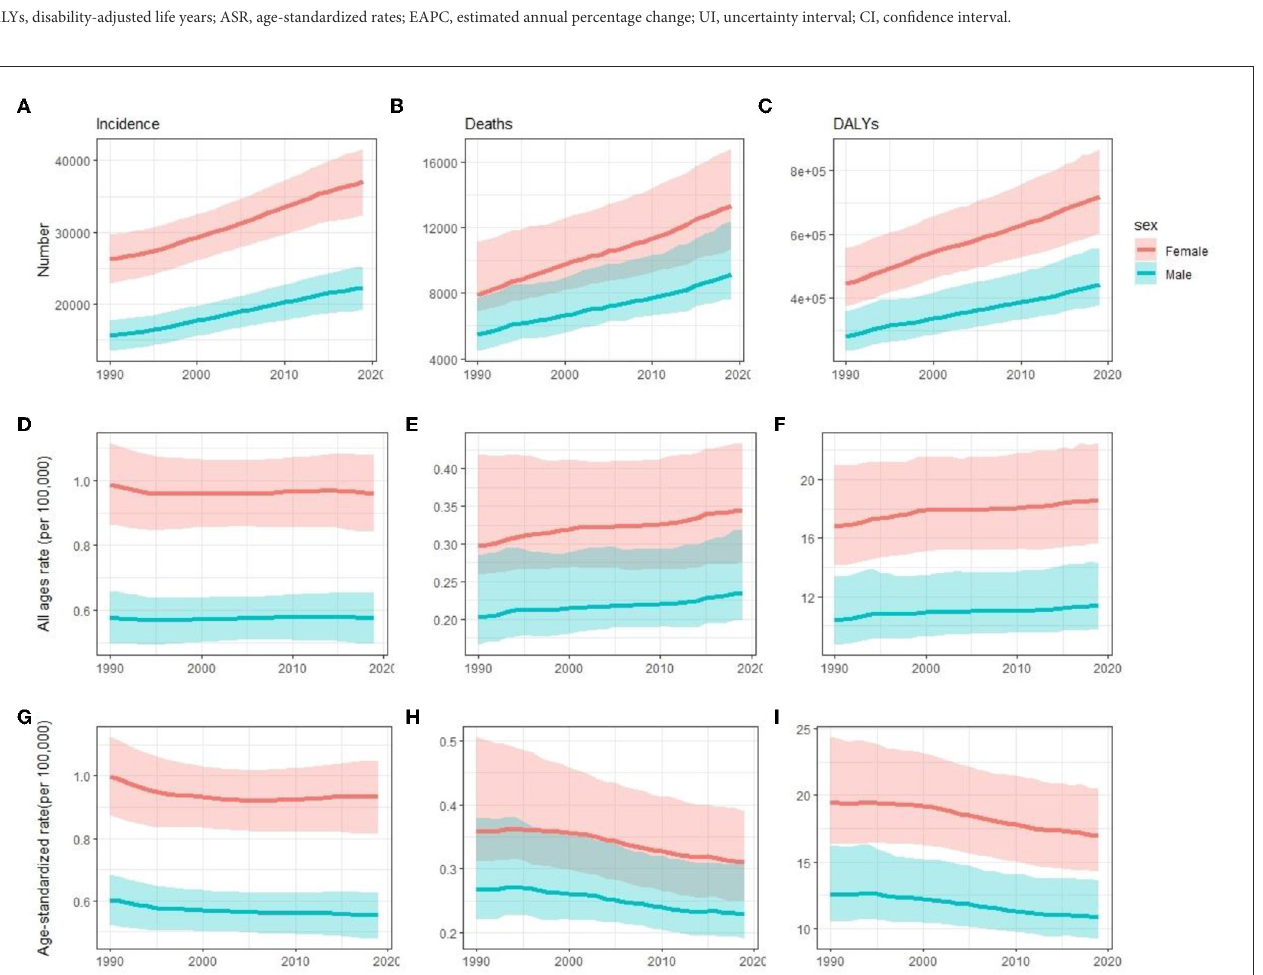
FIGURE1 Comparison of time trends between women and men in incidence (A, D, G) , deaths (B, E, H) , and DALYs (C, F, I) number, all-age rate, and ASR of multiple sclerosis globally for 1990–2019, respectively. Error bars represented the 95% confidence intervals. DALYs, disability-adjusted life years; ASR, age-standardized